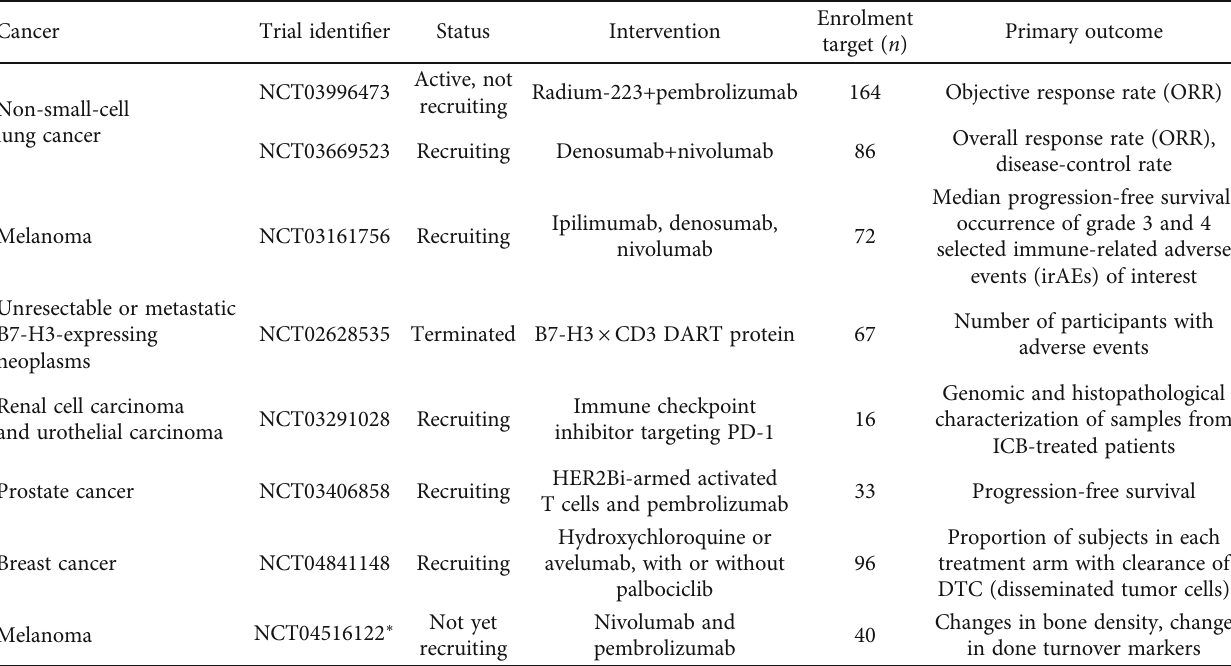
Table 2: Ongoing clinical trials with ICIs in bone